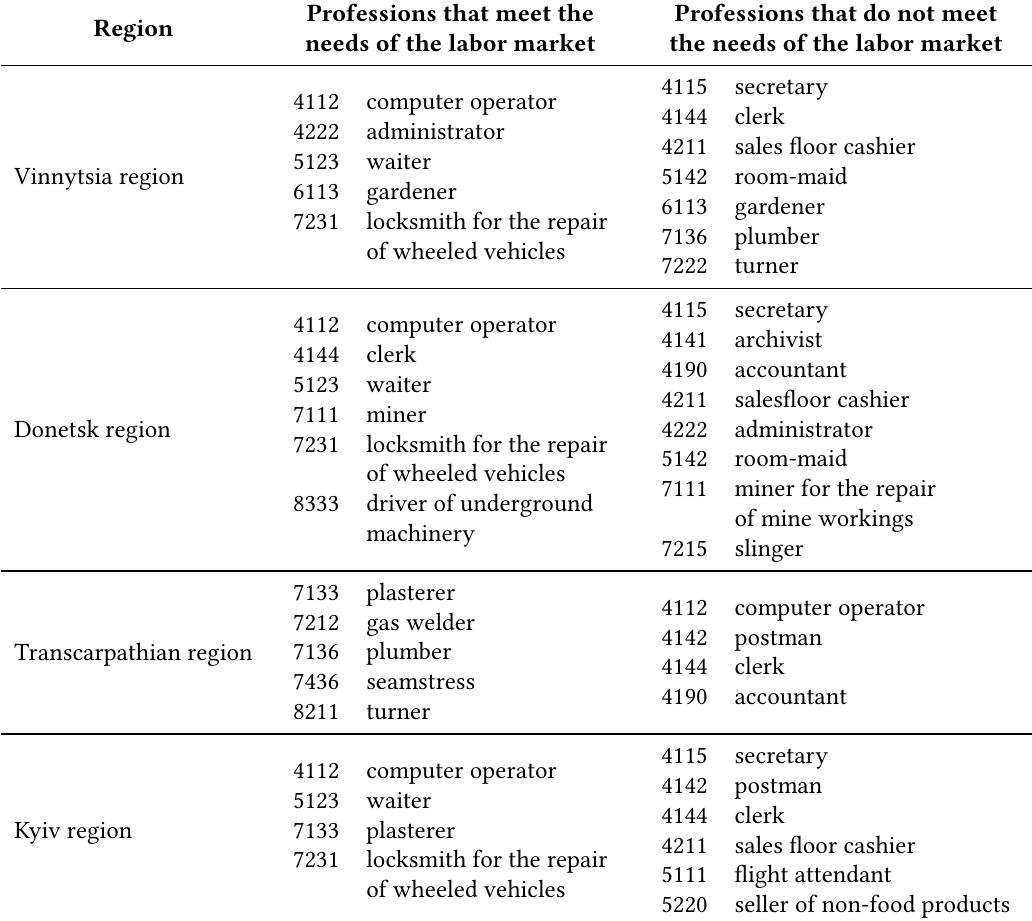
Table 2 Professions offered that coincide (do not coincide) with the needs of the labor market (based on [21]).